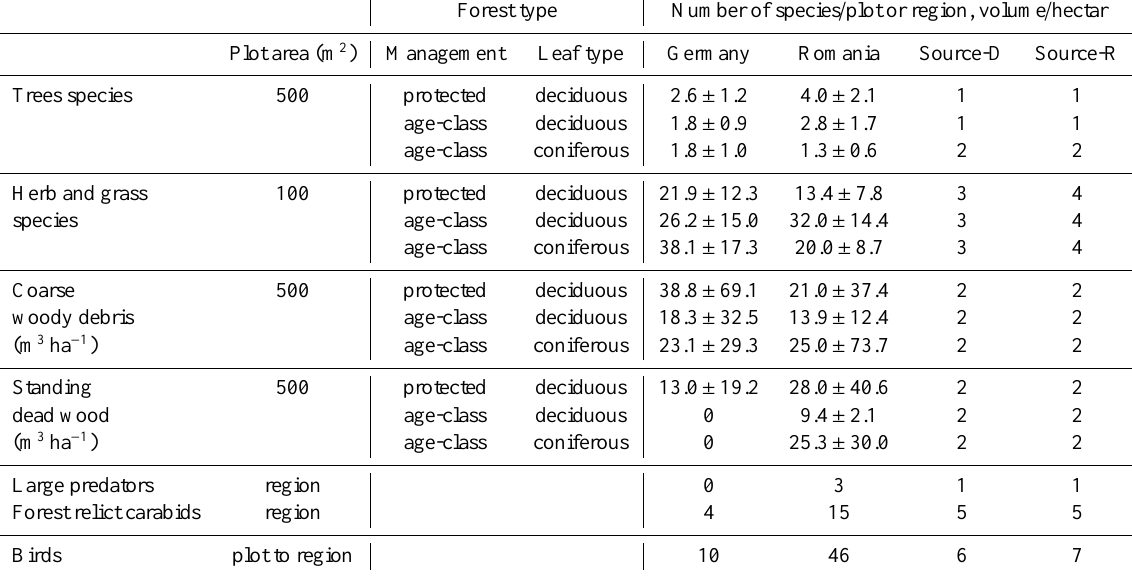
Table 1. Comparative species numbers in di ff erently managed forests of Germany and Romania. The plant data are based on 500m 2 inventory rings for trees and on 100m 2 plots for herbaceous plants. The data are averages over 4771 plots in Romania and 1924 plots in Germany focusing on the montane zone of Fagus and Picea forest (400 to 1000m elevation). The German data refer to Thuringia; the Romanian data represent the whole nation. For birds, the comparison is based on three research areas of about 10 × 20km in Germany, and one 500ha intensive study area in Romania. Large predators are based on a national count in Romania, and on Thuringia in Germany. Sources: 1: Schulze et al. (2013), 2: Hermannsberg, Hainich and Boisoara inventory, Romanian National Forest Inventory, E. D. Schulze, personal communication, 2013, 3: Boch et al. (2013), 4: A. Indreica, personal communication, 2013, 5: Bussler and Müller (2006), Müller et al. (2005), 6: Renner et al. (2013), 7: Walentowski et al.